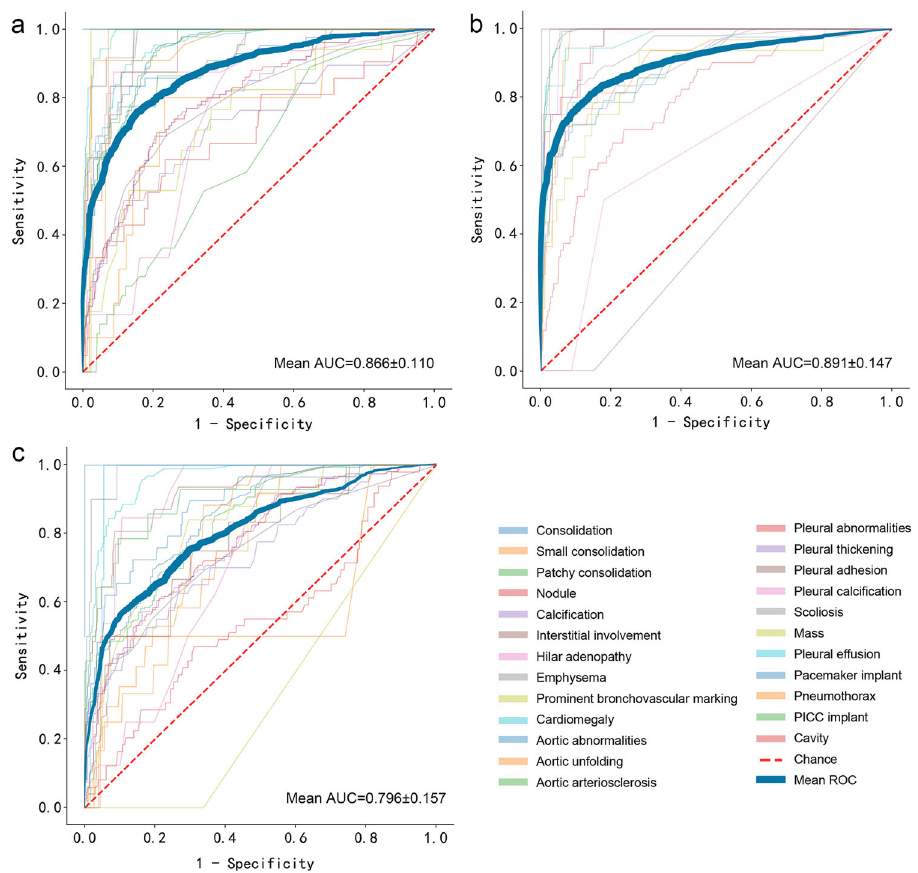
Fig. 3 Receiver operating characteristic (ROC) curves of 25 abnormal signs on CXR in the three external test cohorts. a In the cohort of symptomatic patients in the academic hospital, the mean AUC was 0.866 ± 0.110. The AUCs of major abnormal signs, i.e., consolidation, nodule, mass, pneumothorax, and pleural effusion, were 0.900 (95% CI: 0.849 – 0.943), 0.698 (0.581 – 0.806), 0.977 (0.965 – 0.988), 0.963 (0.925 – 0.991), and 0.988 (0.980 – 0.994), respectively. b In the cohort of asymptomatic screening examinees in the academic hospital, the mean AUC was 0.891 ± 0.147. The AUCs of common signs, i.e., consolidation and nodule, were 0.876 (0.817 – 0.920) and 0.796 (0.725 – 0.838), respectively. c In the cohort of symptomatic patients in eight community clinics, the mean AUC was 0.796 ± 0.157. The AUCs of major signs, i.e., consolidation, nodule, and mass, were 0.873 (95% CI: 0.815 – 0.926), 0.698 (0.619 – 0.771), and 1.000 (0.991 – 1.000),